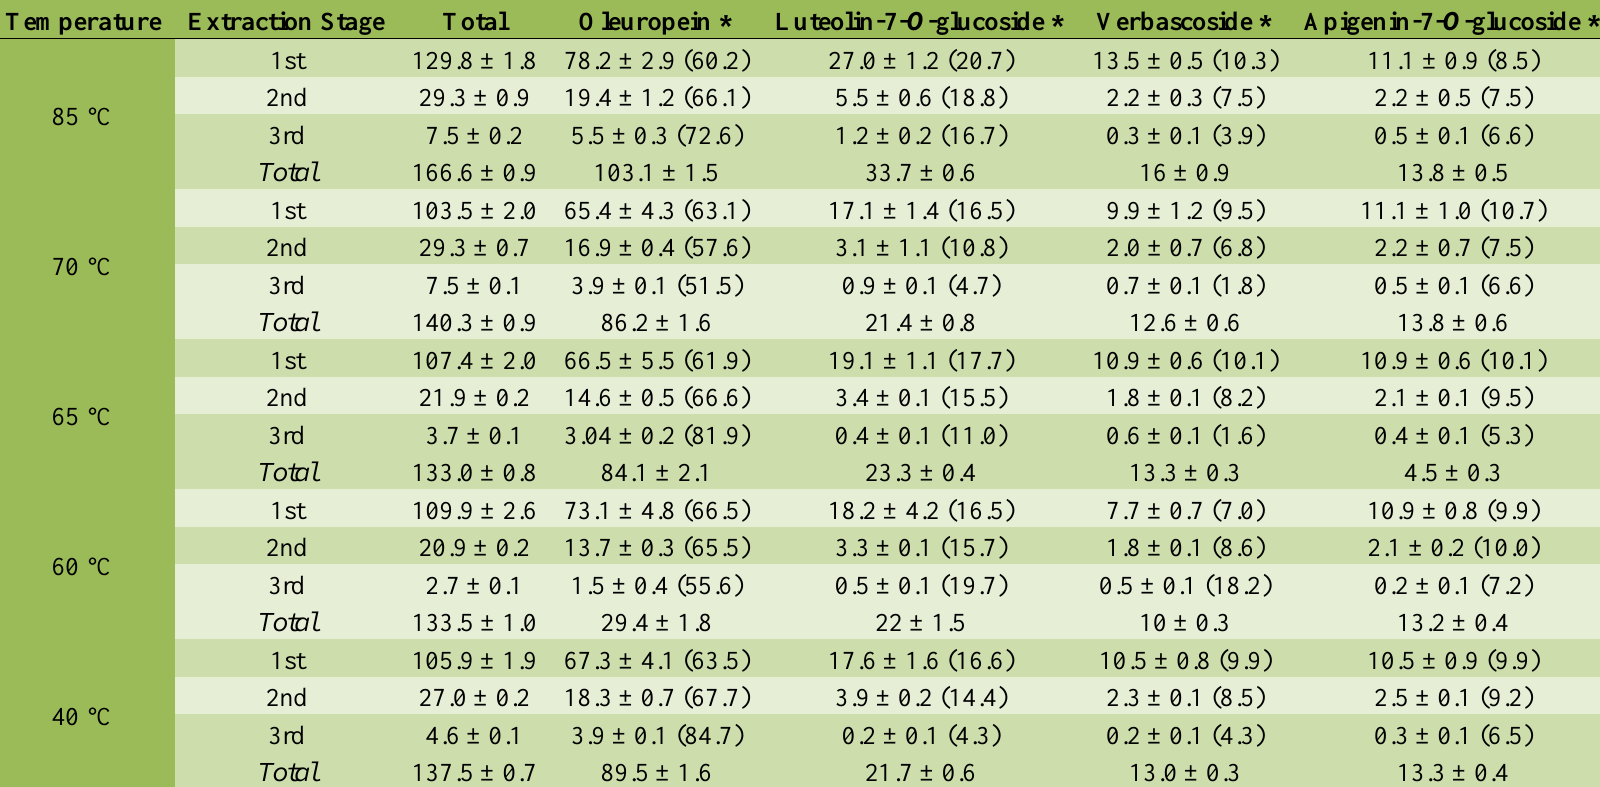
Table 1. Polyphenols composition in olive leaf extract at each extraction stage performed at different temperatures. The values in parenthesis represent the corresponding percentage of phenolic compound in the olive leaf extract at every stage. * Mean values (mg/g d.w. OL) of each phenolic compound at every stage ( n = 6,